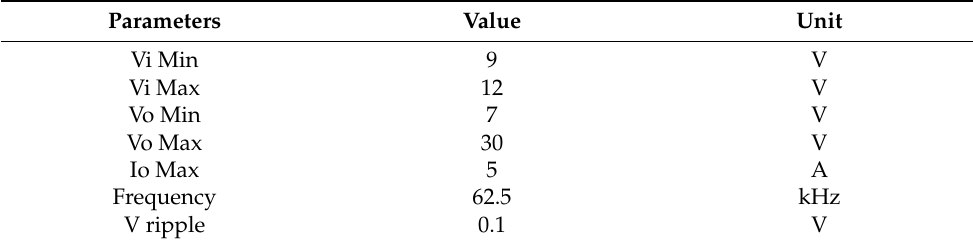
Table 2. Design specification of the proposed buck-boost